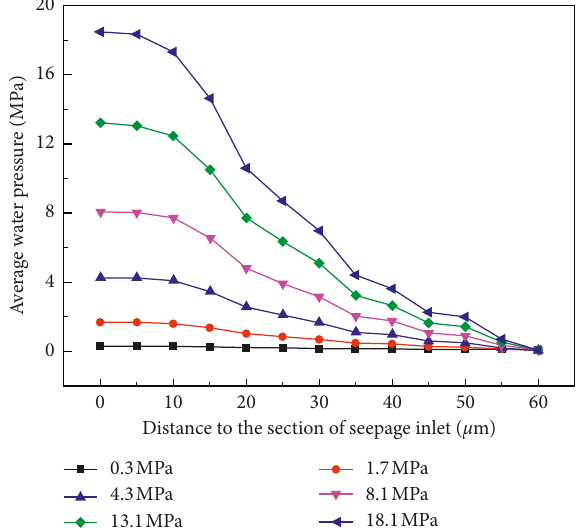
Figure 16: Variations of average seepage pressure with seepage length under different inlet